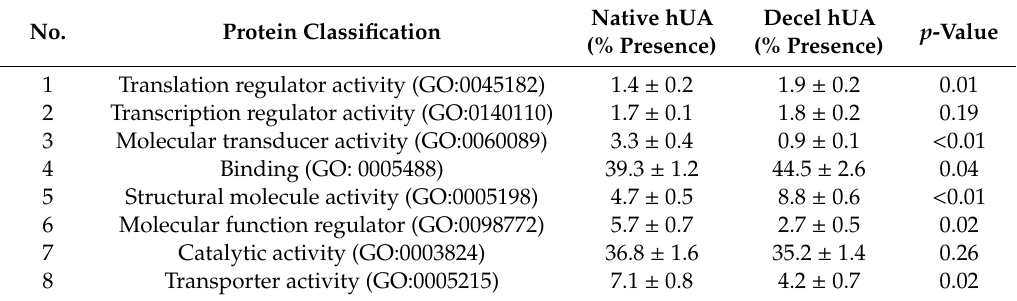
Table 3. Classification of the identified proteins in native and decellularized hUAs. Protein classification based on their molecular function was performed using the Panther analysis